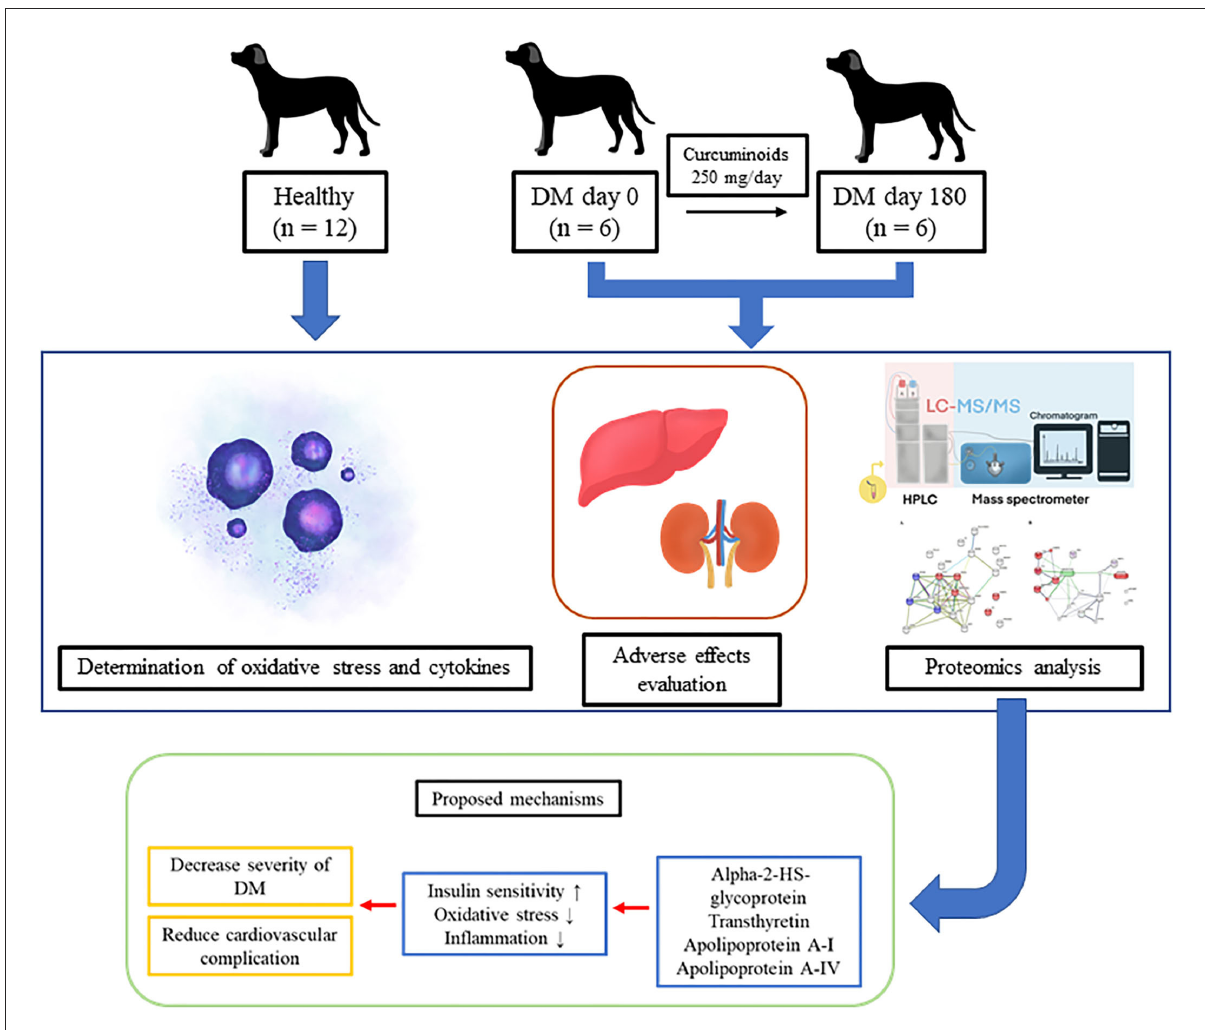
FIGURE5 The improvement of the metabolic pathways influencing insulin sensitivity and cardiovascular events by curcuminoid supplementation in diabetic dogs.